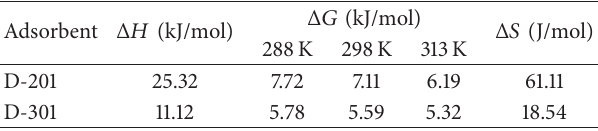
Table 3: Thermodynamic parameters of D-201 and